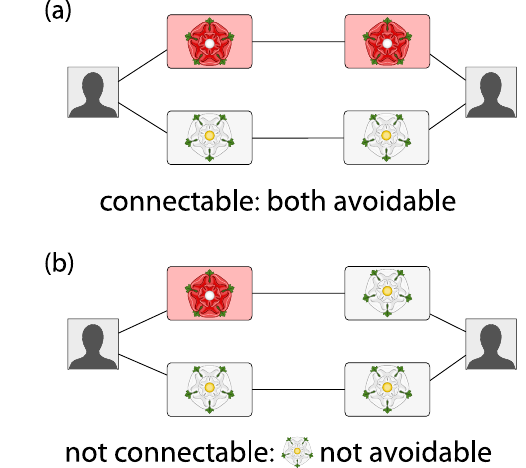
FIG. 1. Avoidable and nonavoidable adversaries. In this sce- nario, the sender must transmit their message through nodes that are controlled by either Lancaster (red rose) or York (white rose). In diagram (a), a message can be split in two and transmitted on two different paths: The upper path avoids York ’ s nodes, while the lower path avoids Lancaster ’ s nodes. In diagram (b), both of the paths pass through York ’ s nodes, and York cannot be avoided. Lancaster and York were opponents in the Wars of the Roses in England in the 15th century. Artwork after Ref.